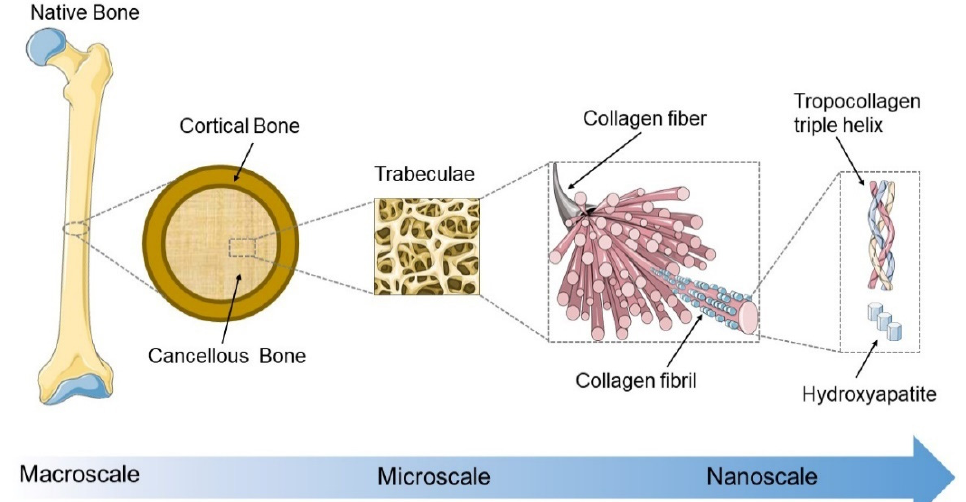
Figure 2. The hierarchical structure of natural bone from macro to nanoscale. The schematic representation of the long bone structure is shown as an example. In the macroscopic view, bone cross-section can be divided into an external and an internal part. The bone external structure consists of compact cortical bone which is composed of densely packed cylindrical osteons. The internal cancellous bone has a porous trabecular structure. Osteons and trabeculae are made up of lamellae with different collagen fiber patterns. The collagen fibers (~1 µ m) are composed of bundles of mineralized collagen fibrils (~100 nm), in which hydroxyapatite nanocrystals (nanoscale size) are deposited in the gaps between collagen molecules (tropocollagen triple helices). The figure was created using Servier Medical Art.